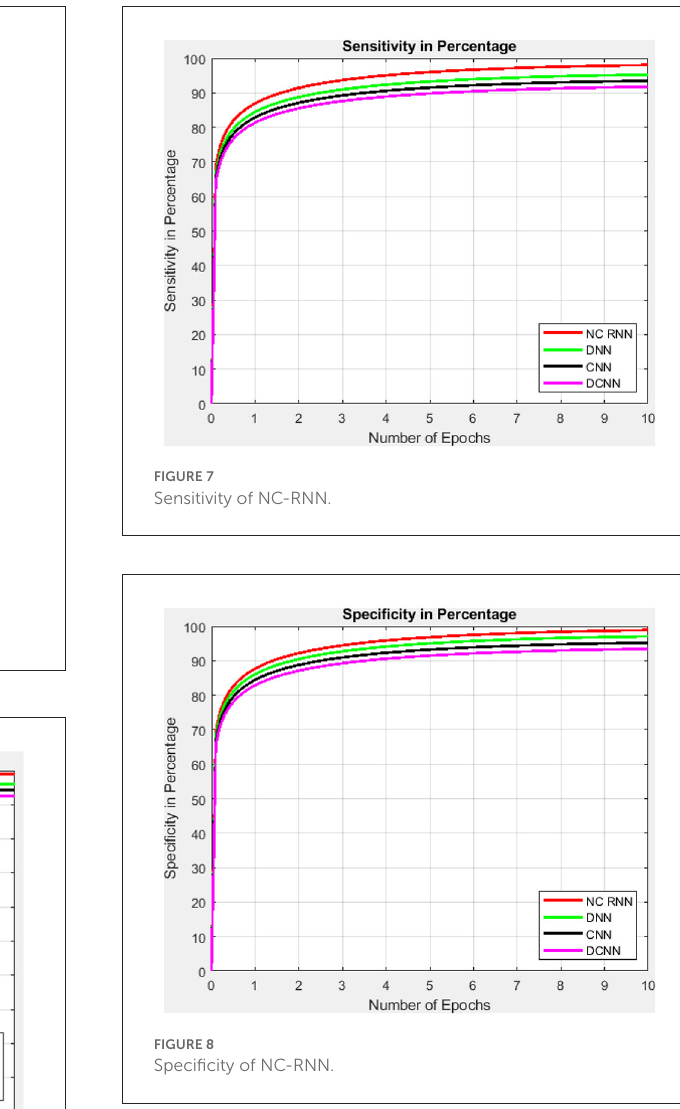
FIGURE6 Accuracy of NC-RNN.